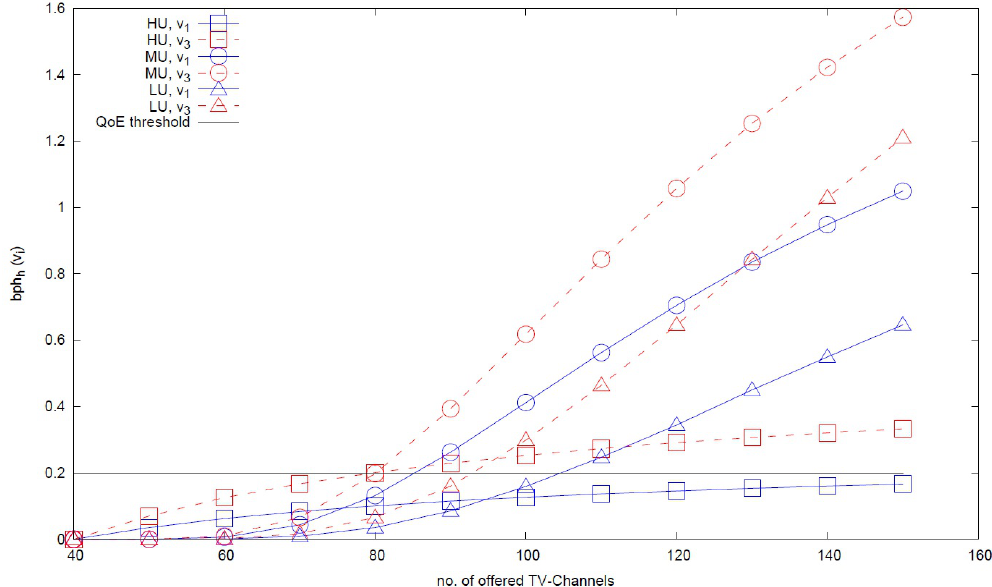
bph ( v ) dependent on the number of offered channels for distinct lanes of h i different traffic scenarios in the early period model.